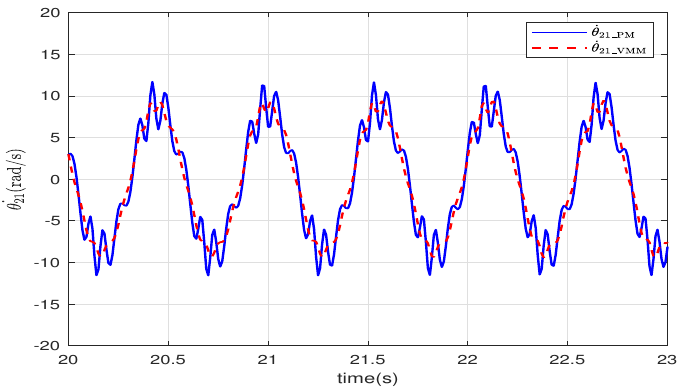
Figure 8. The angular velocity of the tail. Figure 9 shows the output torque of the motor in the second joint. The magnitude of M 2 of the VMM ( M 2_VMM ) is 0.5 Nm less than that of the PM ( M 2_PM ); M 2 of the VMM also changes more smoothly than the PM. In the closed-loop control, the VMM leads the flexibility and adaptability of the muscles into the controller in the joint space. Thus, the joint can adapt to the environment to avoid the output torque changes radically. Thereby, the smoothness of the torque can reduce energy consumption. Figure 10 depicts the feedback signal of the virtual spindle model in the VMM. The fuzzy controller e ( t ) generates the spindle-like feedback signal to regulate the closed-loop controller to fit the disturbances in the environment. e 1 and e 2 are periodic signals transformed from the angular velocity and the angle of the joints. As the torque and the hydrodynamic force interact with the movements of the joints, e 1 and e 2 add the same-frequency virtual spindle signals onto the sinusoidal motion of the joints. Therefore, the body and the tail fin can use the hydrodynamic force of the fluid better to reduce energy consumption and improve propulsive